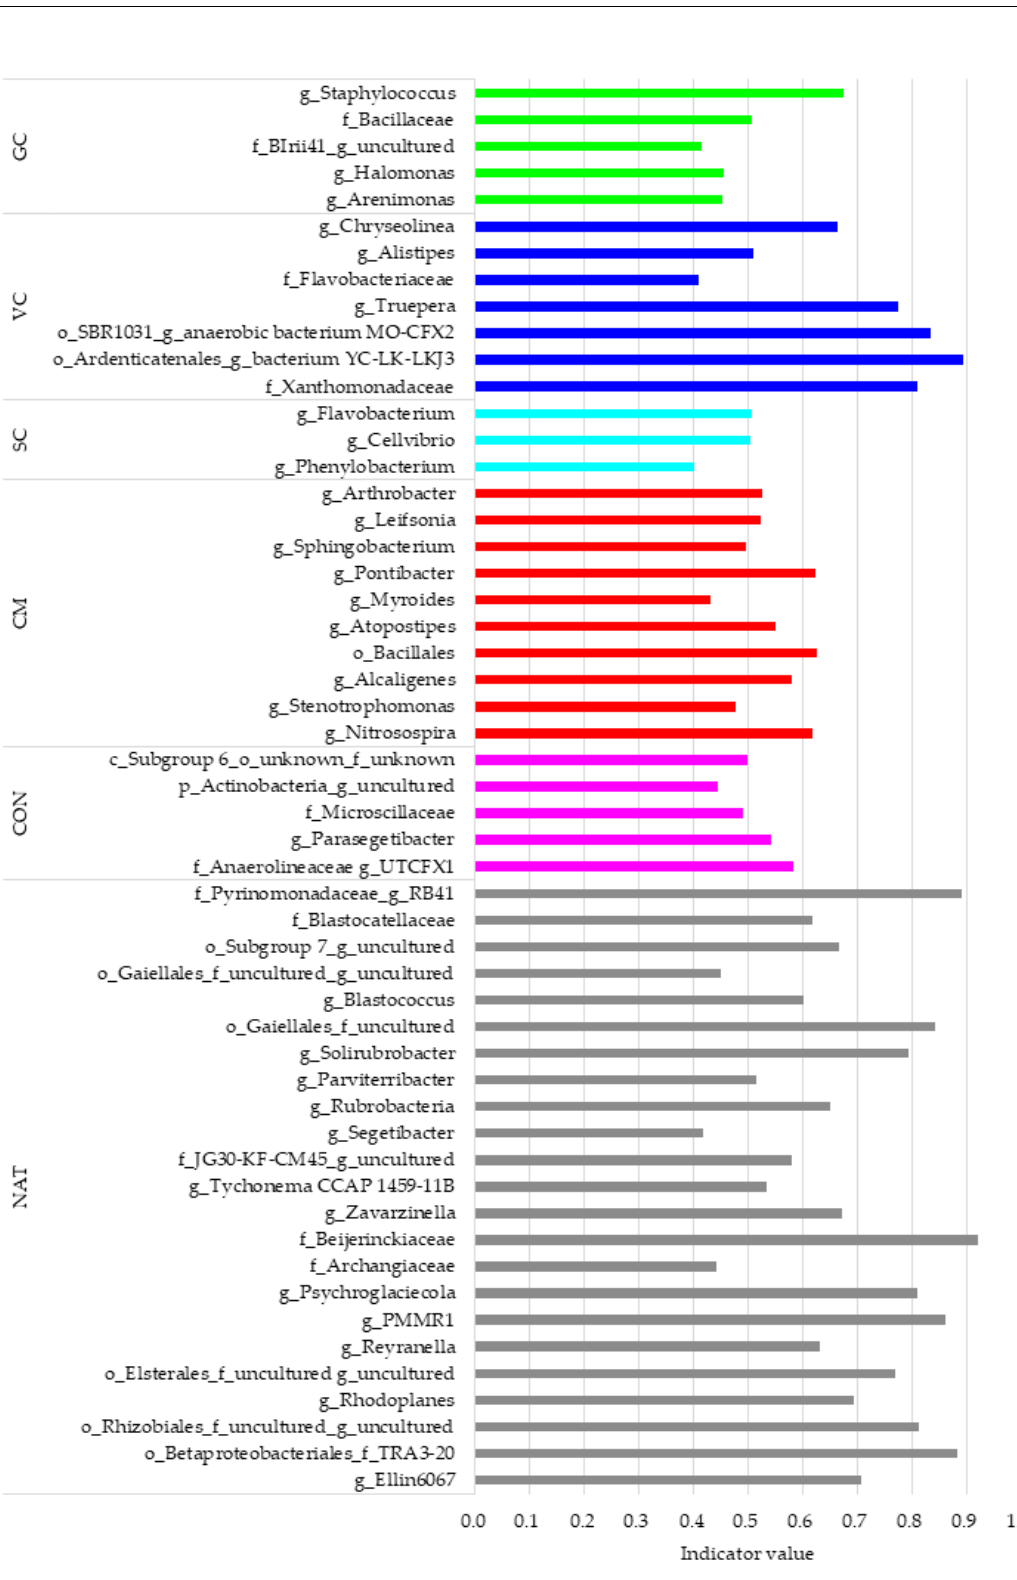
Figure 3. Soil bacterial taxa selected by indicator species analysis for different treatments (restored, control, and natural reference soils). GC: greenhouse crop residues compost; VC: vermicompost; SC: organic compost derived from the mixture of chicken and sheep manure; CM: manure from chickens raised on the soil of organic farms; CON: unamended control soils; NAT: natural reference soil.